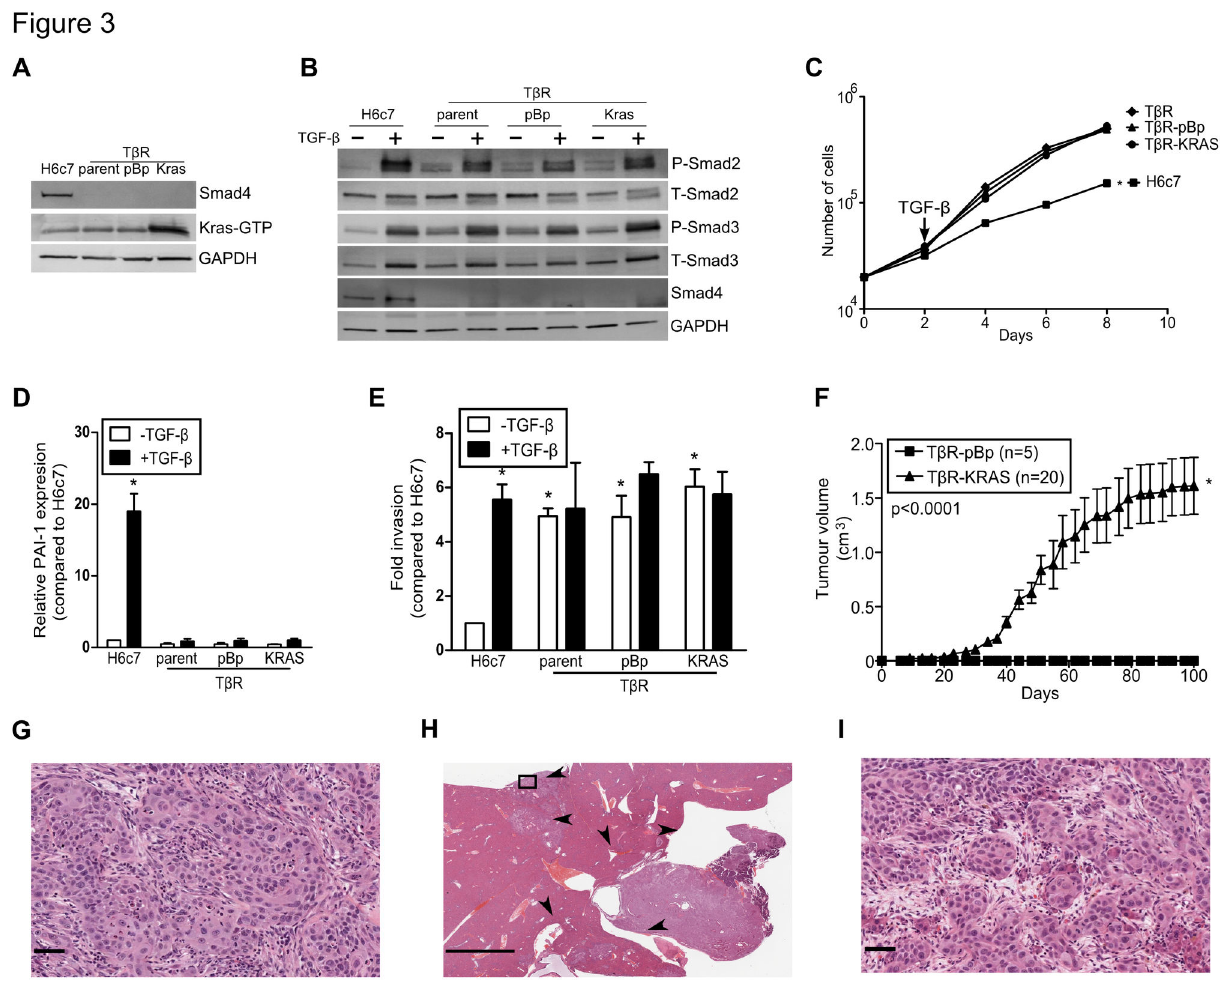
used as a loading control. ( B ) Immunoblots of phospho- and total Smad2/3, and Smad4. GAPDH was used as a loading control. ( C ) Growth curves of H6c7, TβR, TβR pBp, and TβR KRAS with TGF-β. ( D ) PAI-1 mRNA expression was assessed after 48 hours of TGF-β in the H6c7 and TβR cell lines (n=3). ( E ) Invasion assays through Matrigel coated membranes incubated with and without TGF-β (n=6). ( F ) Tumor growth curve after subcutaneous implantation of the TβR-pBp and TβR-KRAS cell lines into NOD-SCID mice (n=20). Representative H&E sections of orthotopic TβR-KRAS ( G ) xenografts and ( H and I ) metastases found in the liver and spleen. (* denotes significant differences between H6c7 and TβR cell lines or treated compared to vehicle where appropriate,